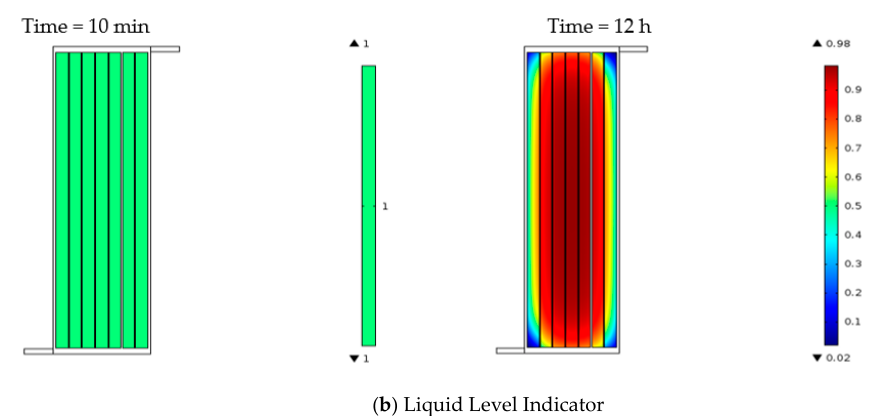
Figure 4. Storage time by: ( a ) temperature and ( b ) liquid level for 10 min and 12 h.